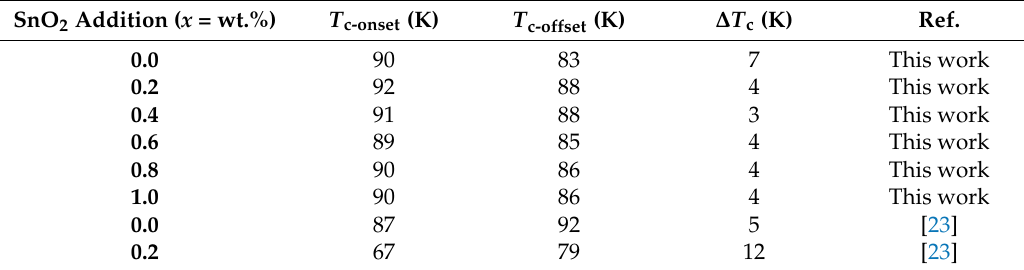
Figure 6. Resistance versus temperature graph for Y-123 with x = 0.0, 0.2, 0.4, 0.6, 0.8, and 1.0 SnO 2 addition. Table 2. T c-onset , T c-offset , and ∆ T c for Y-123 at x = 0.0, 0.2, 0.4, 0.6, 0.8, and 1.0 wt.% SnO 2 addition in this work, and in = 0.0 and 0.2 reported in